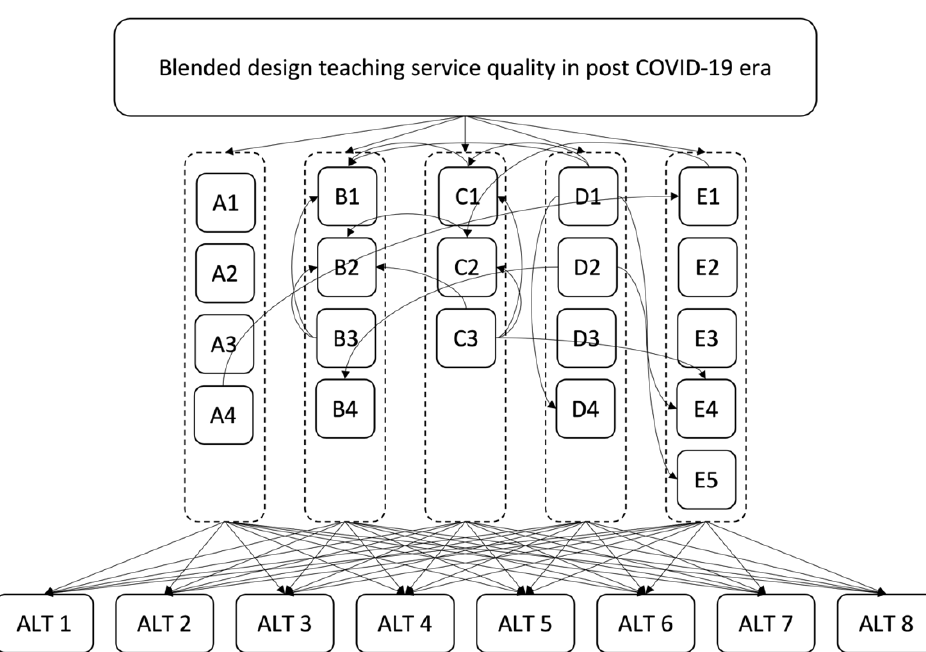
Figure 4. The hierarchy and network structure of this